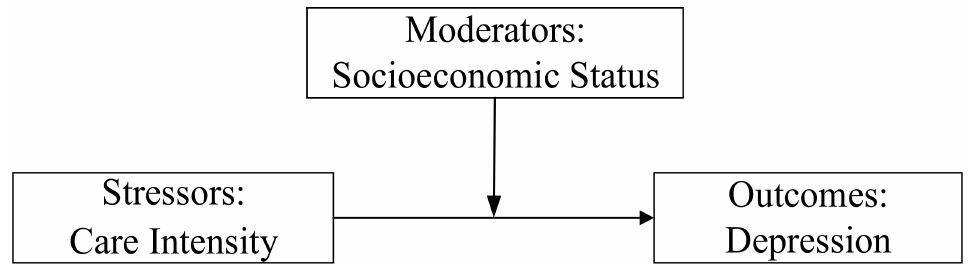
Figure 1. The moderating effect of socioeconomic